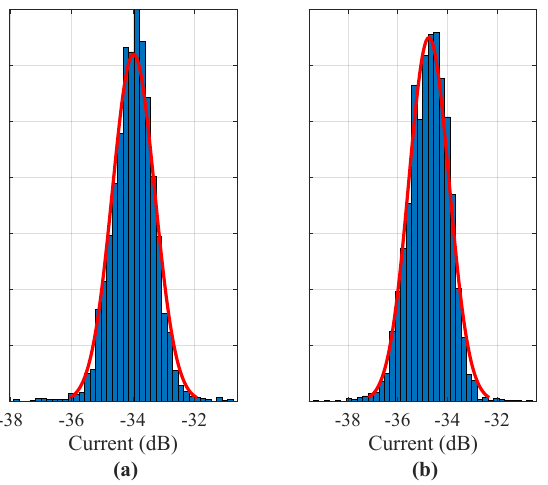
Figure 4. An example of the fluctuations of harmonics power (Equation (4)) at 800 mA load modeled by a lognormal distribution; the distribution is in dB units fitted with the Gaussian PDF for ( a ) 750 Hz harmonic and ( b ) 850Hz